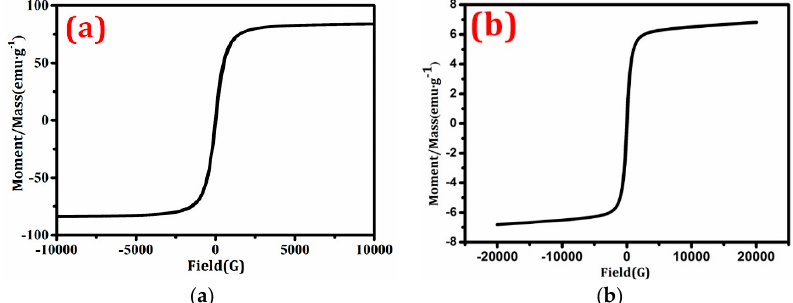
Figure 5. N 2 adsorption-desorption isotherms and pore size distribution curves (insert) of BiVO 4 /Mn 1 − x Zn x Fe 2 O 4 (15 wt %).